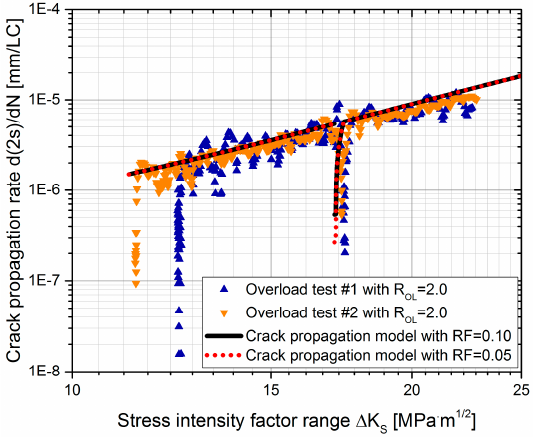
Figure 8. Comparison of crack propagation model with results of Overload test #1 and #2.